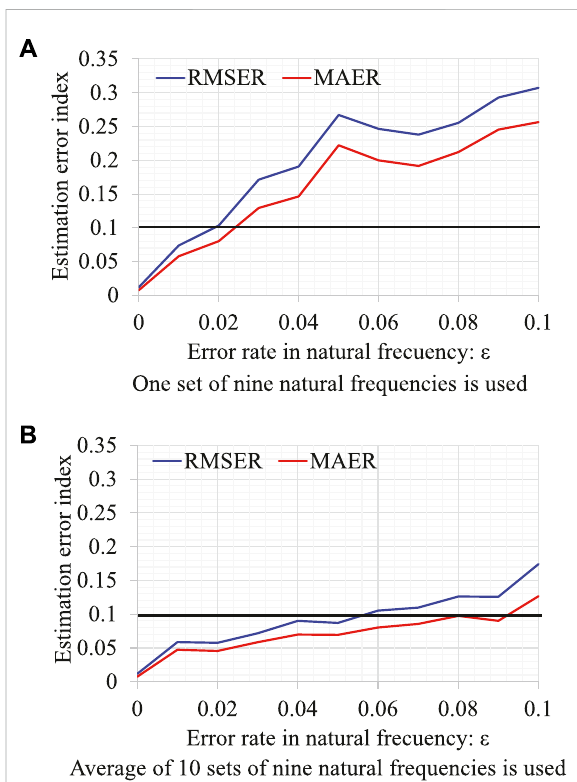
FIGURE 7 Effect of measurement errors on tension estimation error index. (A) One set of nine natural frequencies is used. (B) Average of 10 sets of nine natural frequencies is